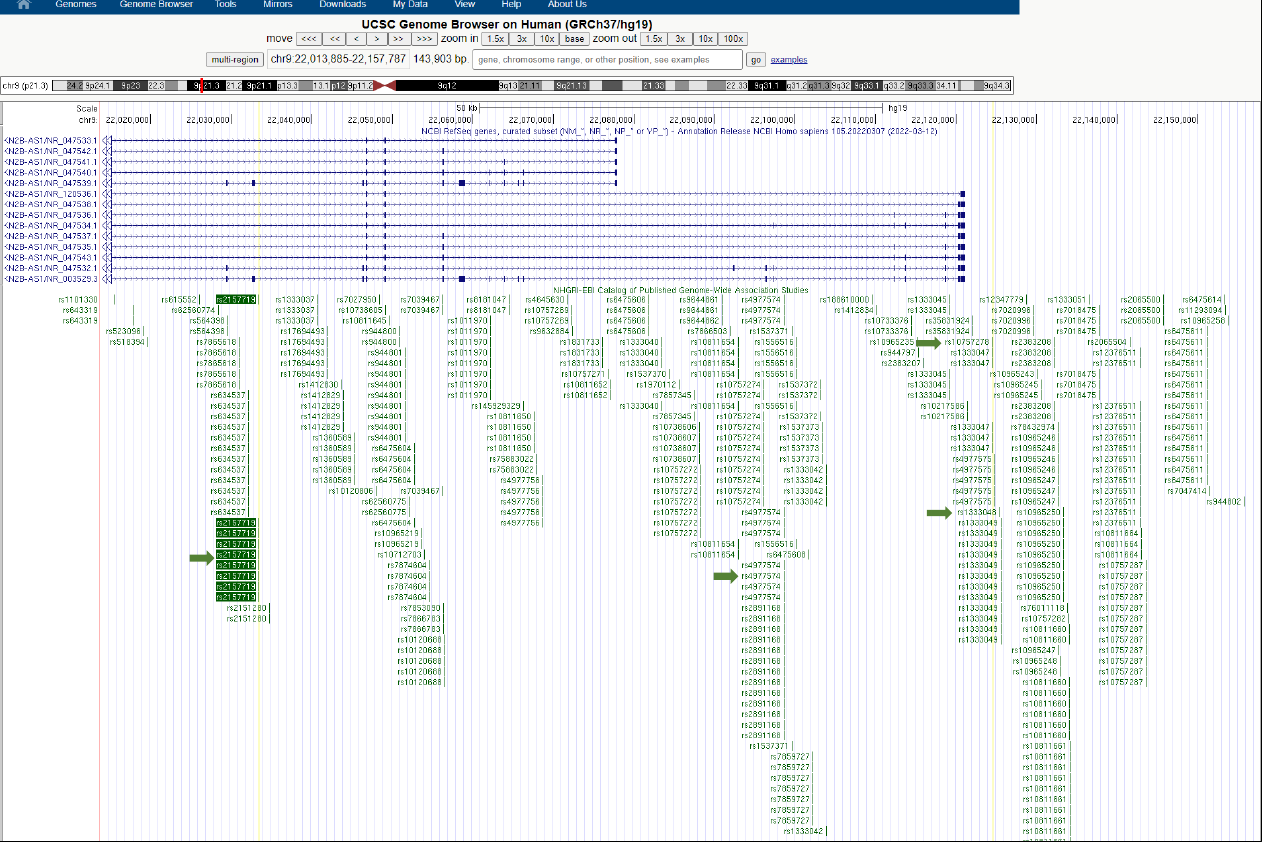
Figure 1. UCSC Genome Browser view of the human CDKN2B-AS1 gene. CDKN2B-AS1 (CDKN2B antisense RNA 1) is a lncRNA gene, also known as ANRIL. The SNP rs2157719 is intronic to CDKN2B-AS1 and it is surrounded by a large number of other significantly disease-associated SNPs in close proximity on the NHGRI-EBI GWAS Catalog track of the UCSC Genome Browser (a “SNP cloud”). Green arrows indicate the SNP rs2157719 associated with T2D and cancer, and the SNPs rs1333048, rs4977574, and rs10757278 associated with cancer.